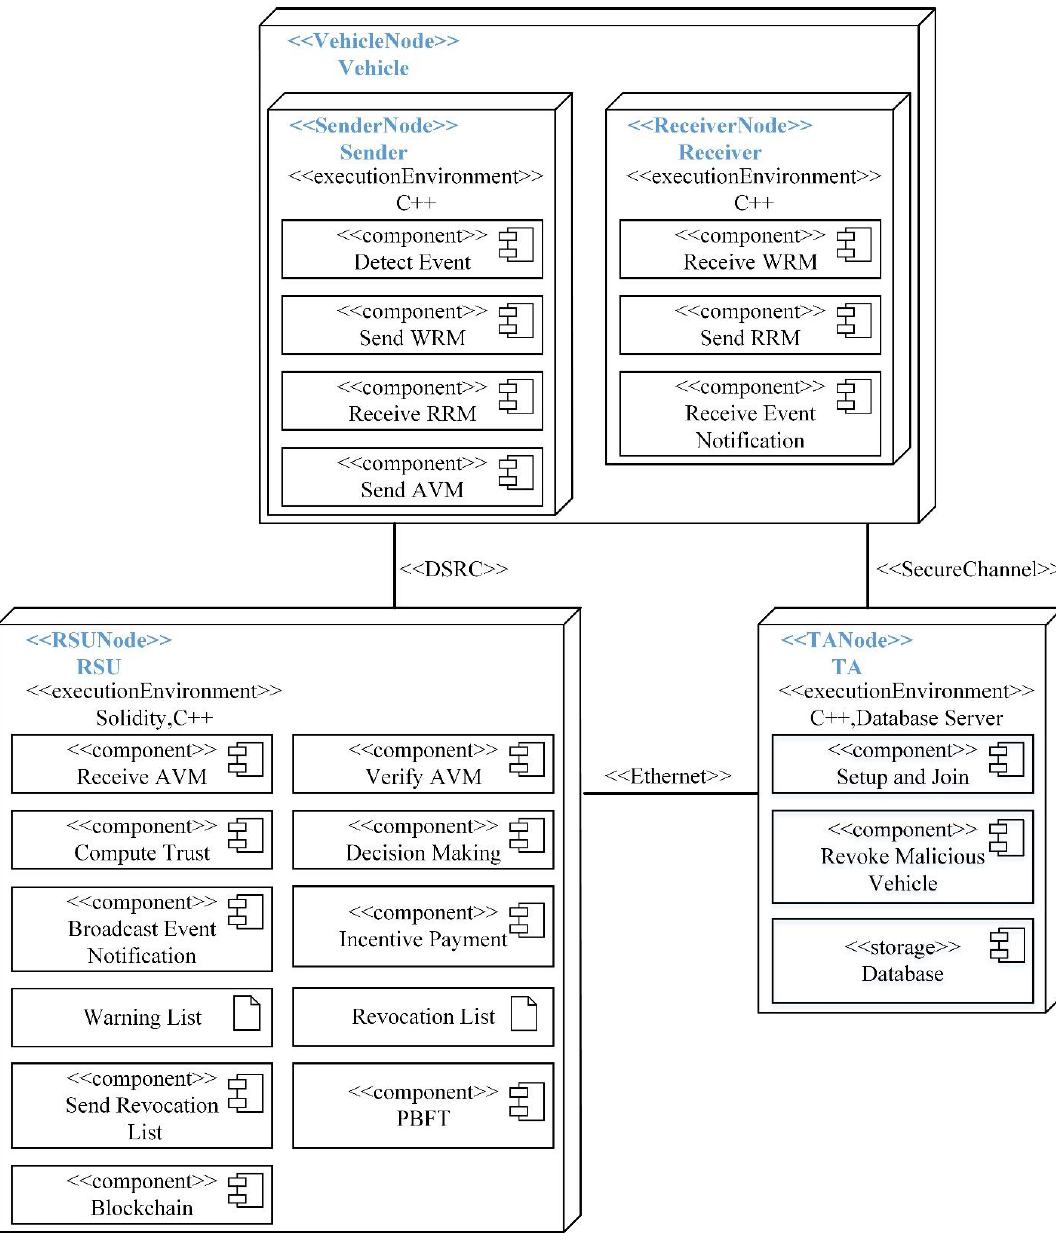
Figure 4. The UML deployment diagram of the proposed